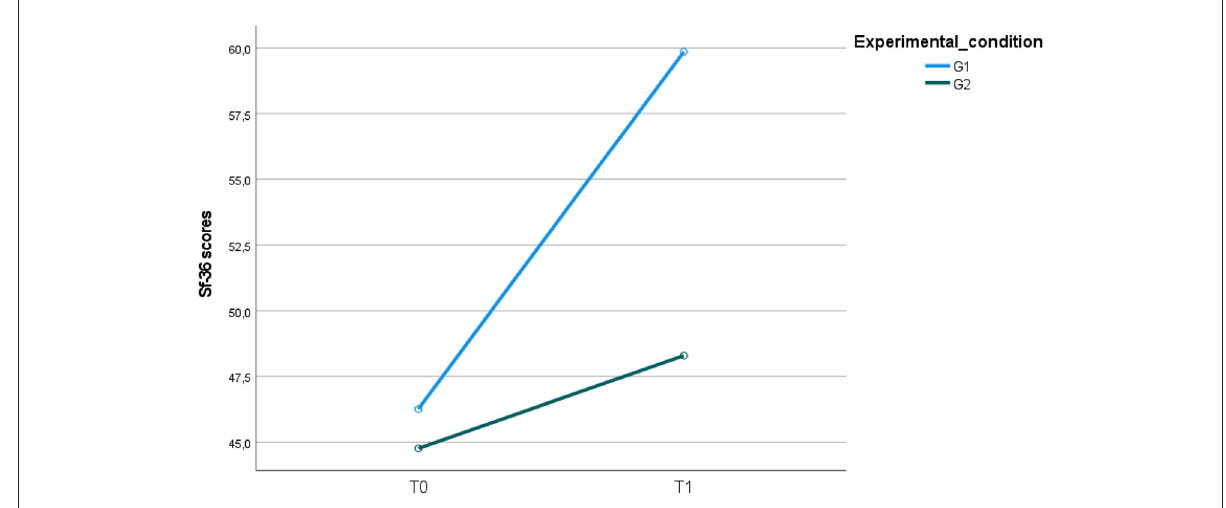
FIGURE7 Health-related quality of life (SF-36) scores in the two psychiatric samples (G1, G2) at T0 and